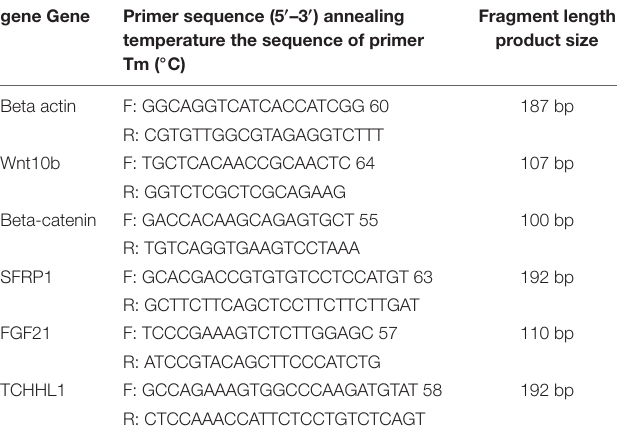
TABLE 2 | The primer sequences for RT-qPCR of cashmere goat gene. gene Gene Primer sequence (5 (cid:48) –3 (cid:48) ) annealing